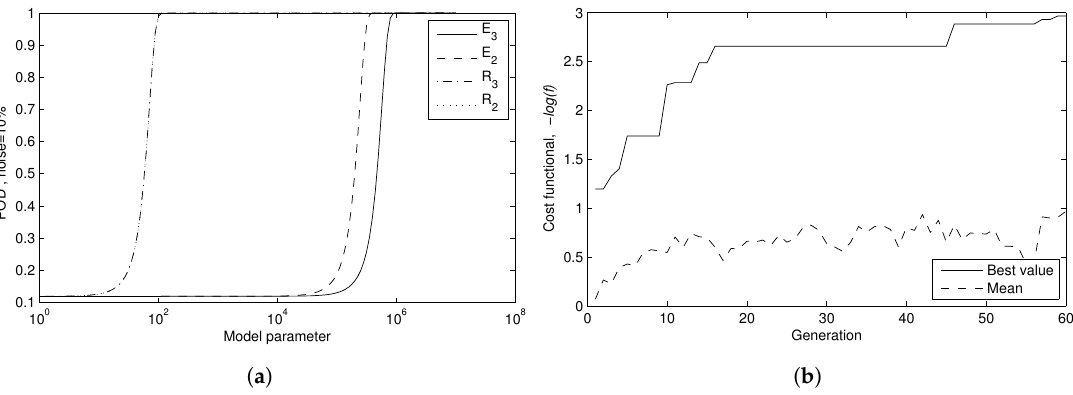
Figure 8. Results of phase 1. ( a ) POD dependency on mechanical properties; ( b ) convergence evolution of Design